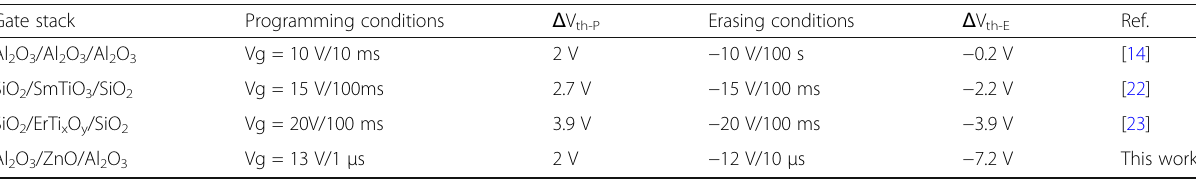
Table 1 Comparisons of the programming and erasing characteristics of various a-IGZO TFT memories with different gate stacks Gate